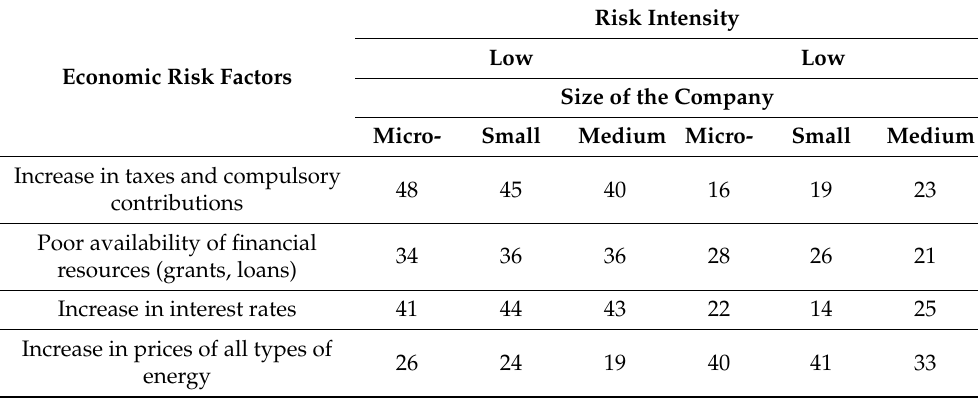
Table 2. Percentage of economic risk intensity broken down by the size of the